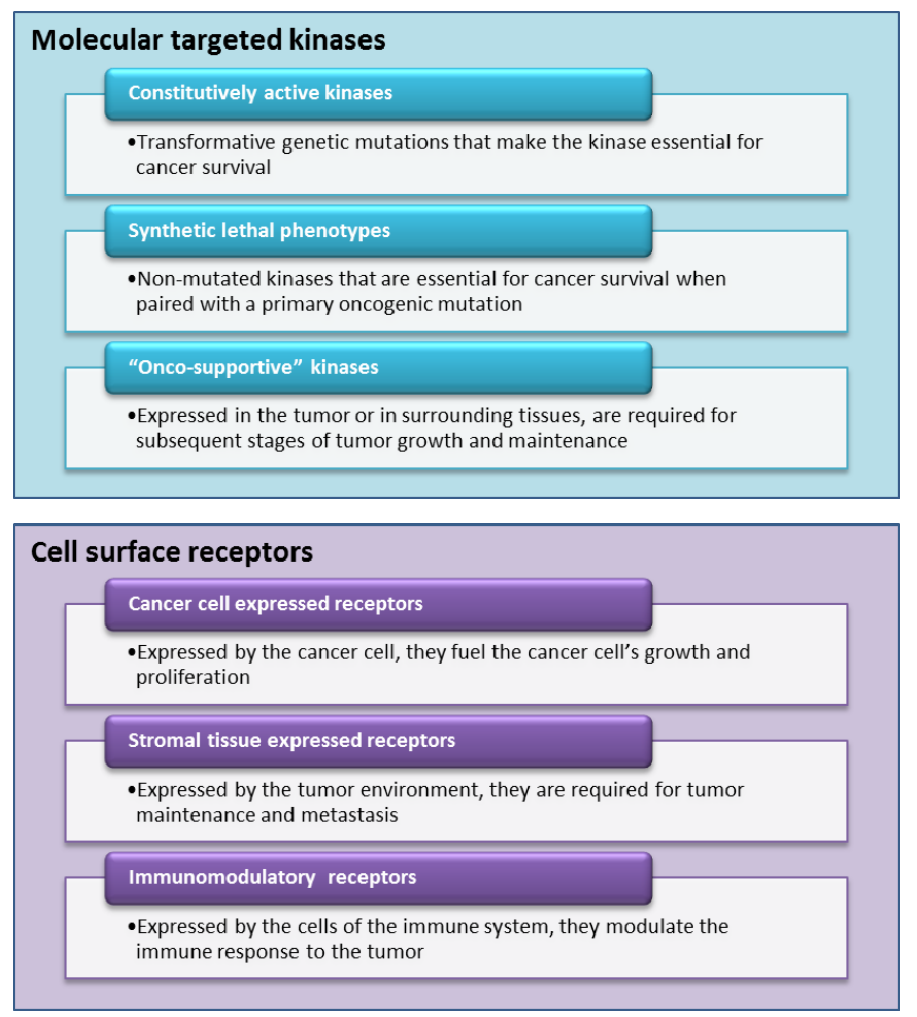
Figure 2. Selective look at ‘new mode of action’ (MoA) currently in